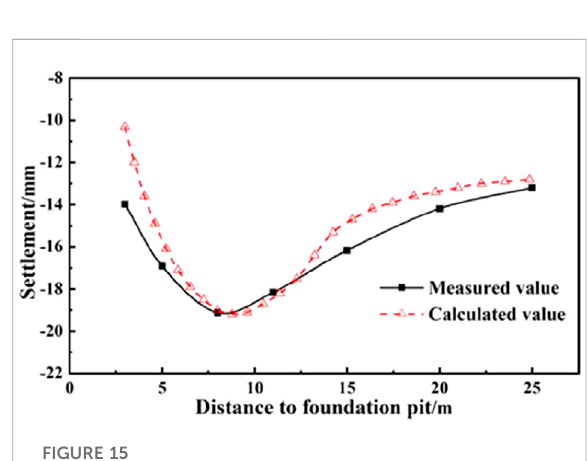
FIGURE 15 Comparison curve of surface settlement behind